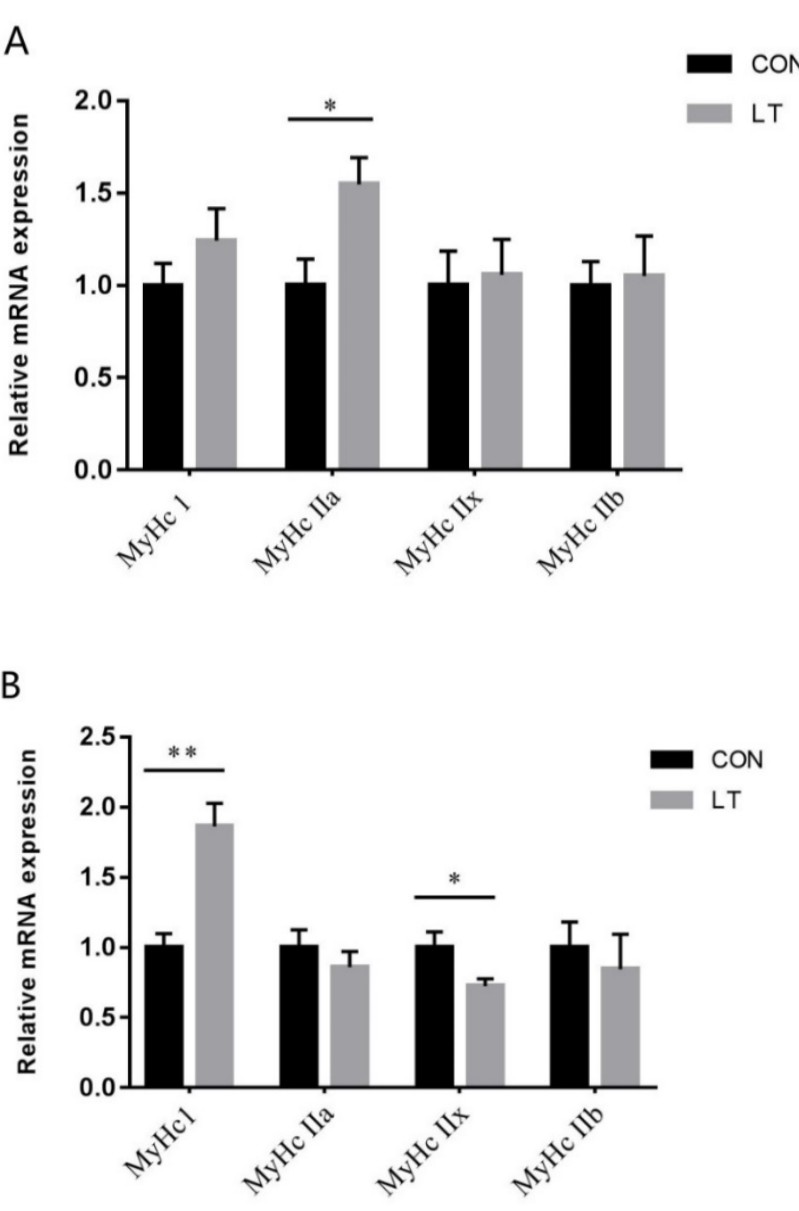
Figure 1. Effects of low-temperature on the mRNA expression level of fiber type-related genes in ( A ) LM and ( B ) PM of weaned piglets. Results were the mean and standard errors. LM, longissimus dorsi muscle; PM, psoas muscle. * Mean values were significantly different between two groups ( p < 0.05). ** Mean values were very significantly different between two groups ( p < 0.01). As shown in Figure 2A, compared with the CON group, LT increased ( p < 0.05) the mRNA expression of CS and SDHB in LM, but had no effect ( p > 0.05) on CPT-1b and Nrf-1 mRNA levels. As shown in Figure 2B, increased CS ( p < 0.05) and CPT-1b ( p < 0.01) mRNA levels were observed in the LT group in PM, but there were no effects ( p > 0.05) on SDHB and Nrf-1 mRNA